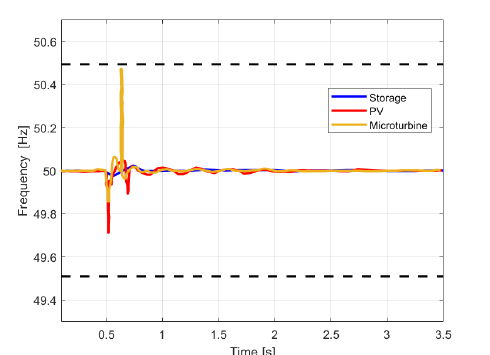
Figure 6. Simulation A: Frequencies. The dashed black lines represent the frequency limits f min and f max .